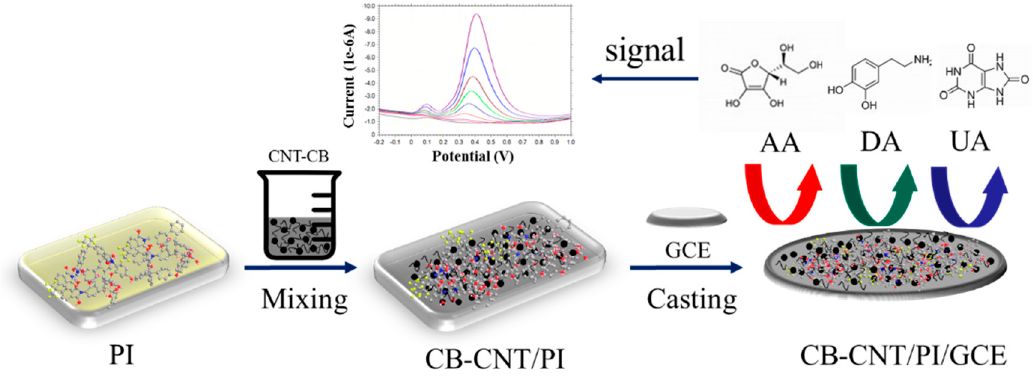
Scheme 1. Schematic representation of the fabrication of carbon black-carbon nanotube